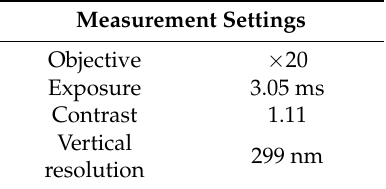
Table 2. Alicona measurement settings for µ